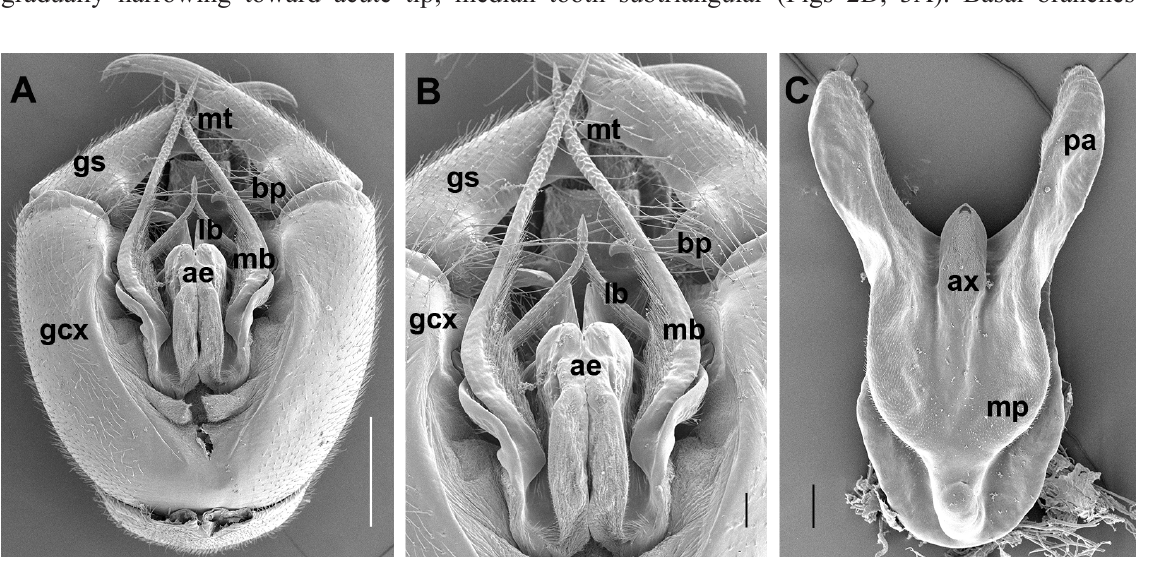
ventral view, with hypandrium removed. B . Magnification of A. C . ♀, medigynium, ventral view. Scale bars: A = 0.5 mm; B–C = 0.1